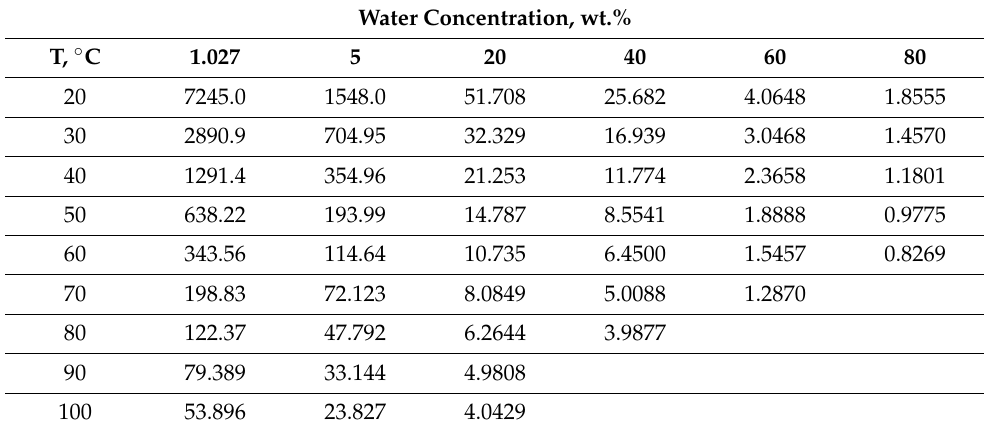
Table 3. Dynamic viscosity of AEPA-Gl aqueous solutions, mPa · s. Water Concentration, wt.%